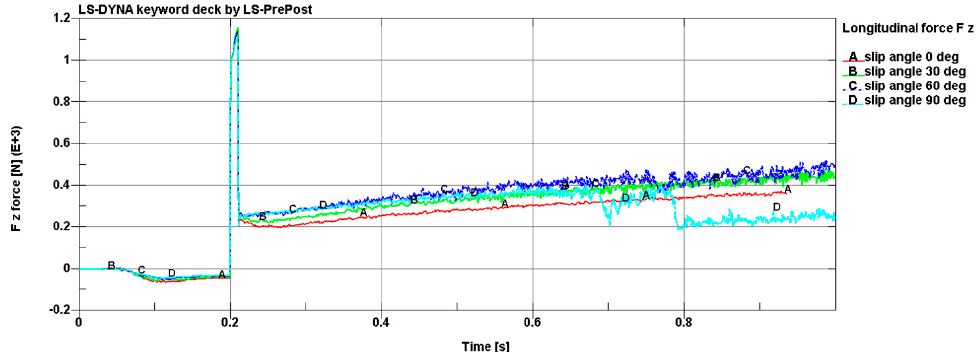
Figure 17. The distribution of the longitudinal force as a function of time for the range of slip